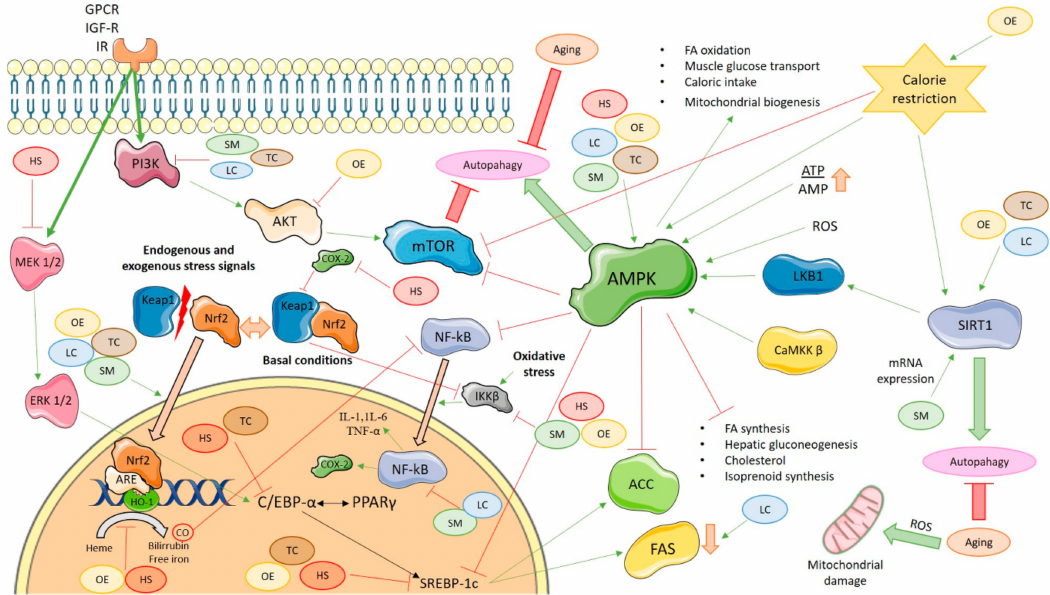
Figure 1. Molecular signaling pathways that are activated or inactivated by dietary phenolics or their metabolitesinoxidativestress,inflammationprocess,andaging. SM: Silybummarianum ; LC: Lippiacitriodora ; HS: Hibiscus sabdariffa ; TC: Theobroma cacao ; OE: Olea europaea; AMPK: AMP-activated protein kinase; mTOR: